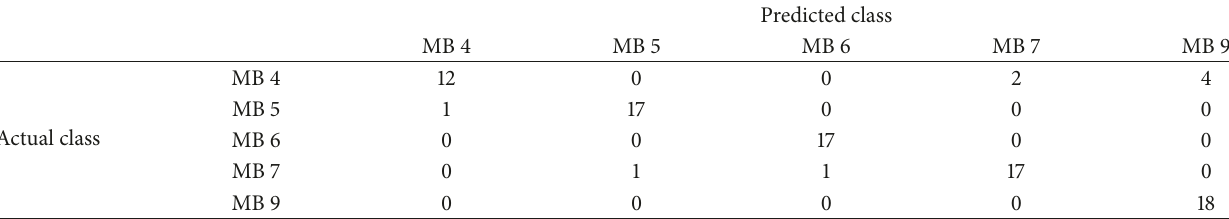
Table 3: Confusion matrix from decision tree in the training process.